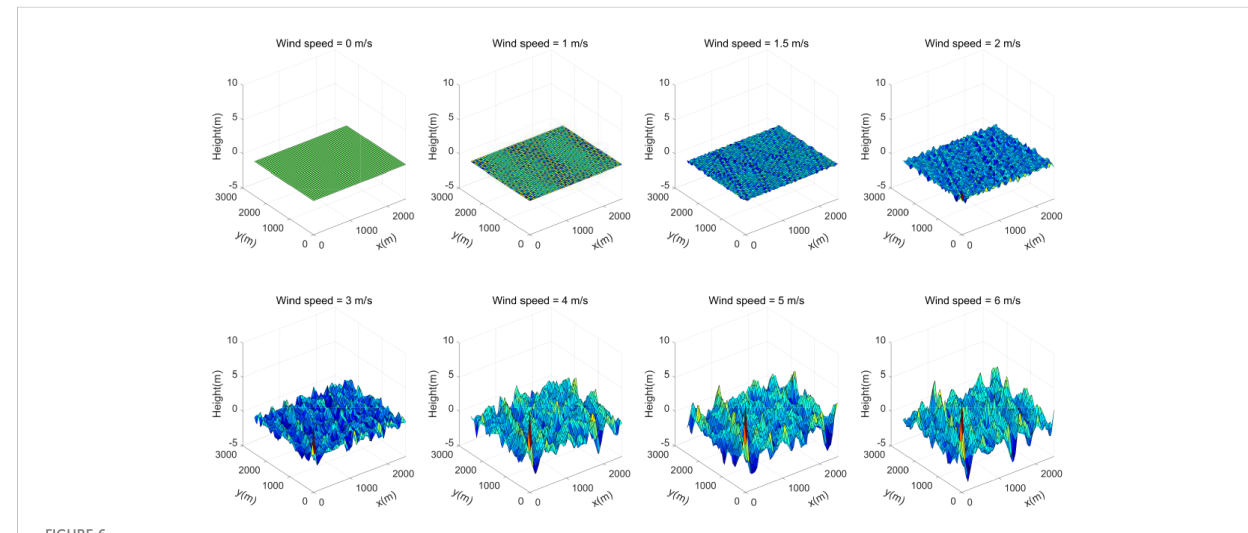
FIGURE 6 Simulated sea surface morphology under varying wind